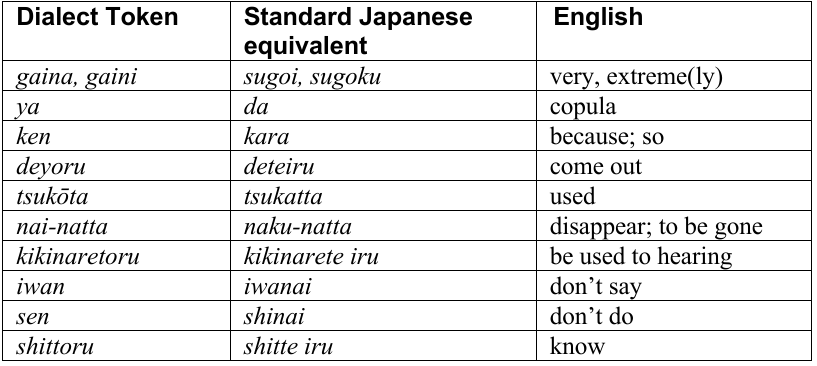
Table 1. Dialect in the